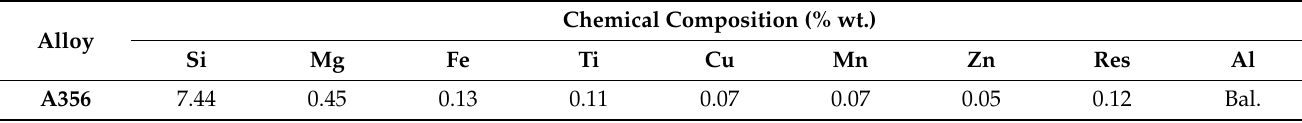
Table 1. AlSi7Mg aluminum alloy chemical composition.